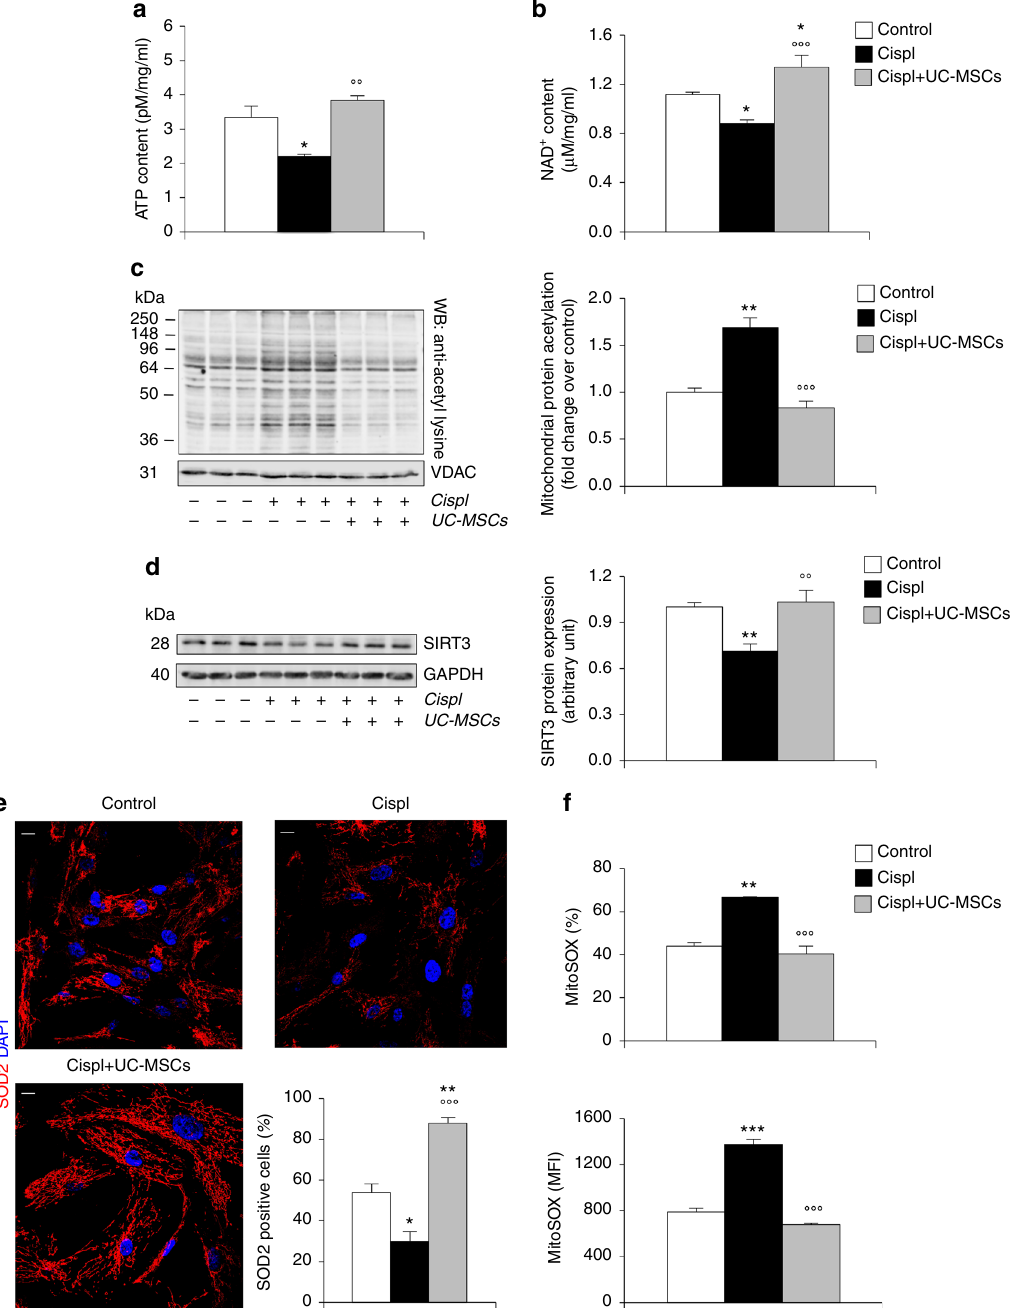
Fig. 3 Human UC-MSCs regulate SIRT3 mitochondrial targets involved in the recovery of cisplatin-injured RPTECs. a Evaluation of ATP content in control RPTECs, cisplatin-treated RPTECs alone or co-cultured with UC-MSCs ( n = 3 independent experiments). * P < 0.05 vs Control and °° P < 0.01 vs Cispl using ANOVA corrected with Bonferroni coef fi cient. b Evaluation of NAD + content in control RPTECs, cisplatin-treated RPTECs alone or co-cultured with UC-MSCs ( n = 6 independent experiments). * P < 0.05 vs Control and °°° P < 0.001 vs Cispl using ANOVA corrected with Bonferroni coef fi cient. c Representative western blots and densitometric analysis of protein acetylation in mitochondria isolated from control RPTECs, cisplatin-treated RPTECs alone or co-cultured with UC-MSCs ( n = 3 independent experiments). Molecular weights (kDa) are shown on the left. ** P < 0.01 vs Control and °°° P < 0.001 vs Cispl using ANOVA corrected with Bonferroni coef fi cient. d Representative western blots and densitometric analysis of SIRT3 protein expression in control RPTECs, cisplatin-treated RPTECs alone, or co-cultured with UC-MSCs ( n = 6 independent experiments). ** P < 0.01 vs Control and °° P < 0.01 vs Cispl using ANOVA corrected with Bonferroni coef fi cient. e Representative images and quanti fi cation of SOD2 (red) protein expression by immuno fl uorescence analysis in control RPTECs, cisplatin-treated RPTECs alone or co-cultured with UC-MSCs ( n = 3 independent experiments). Nuclei are counterstained with DAPI (blue). Scale bar 10 μ m. * P < 0.05, ** P < 0.01 vs Control, and °°° P < 0.001 vs Cispl using ANOVA corrected with Bonferroni coef fi cient. f Evaluation of mitochondrial superoxide generation by MitoSOX fl uorescent probe and expressed as both the percentage of ROS producing cells (%, upper panel) and the mean fl uorescence intensity (MFI, lower panel) in control RPTECs, cisplatin-treated RPTECs alone or co-cultured with UC-MSCs ( n = 3 independent experiments). ** P < 0.01, *** P < 0.001 vs Control and °°° P < 0.001 vs Cispl using ANOVA corrected with Bonferroni coef fi cient. Data in a – f are expressed as mean ±